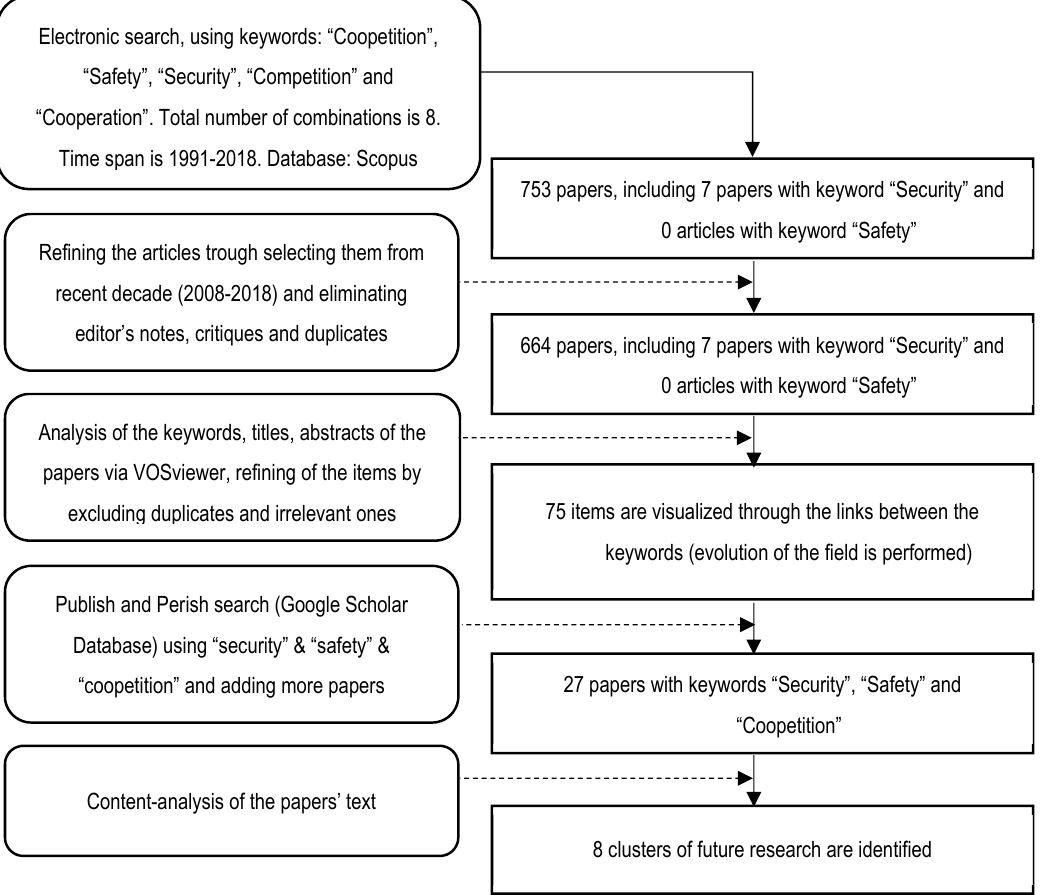
Figure 2. Systematic process of research.